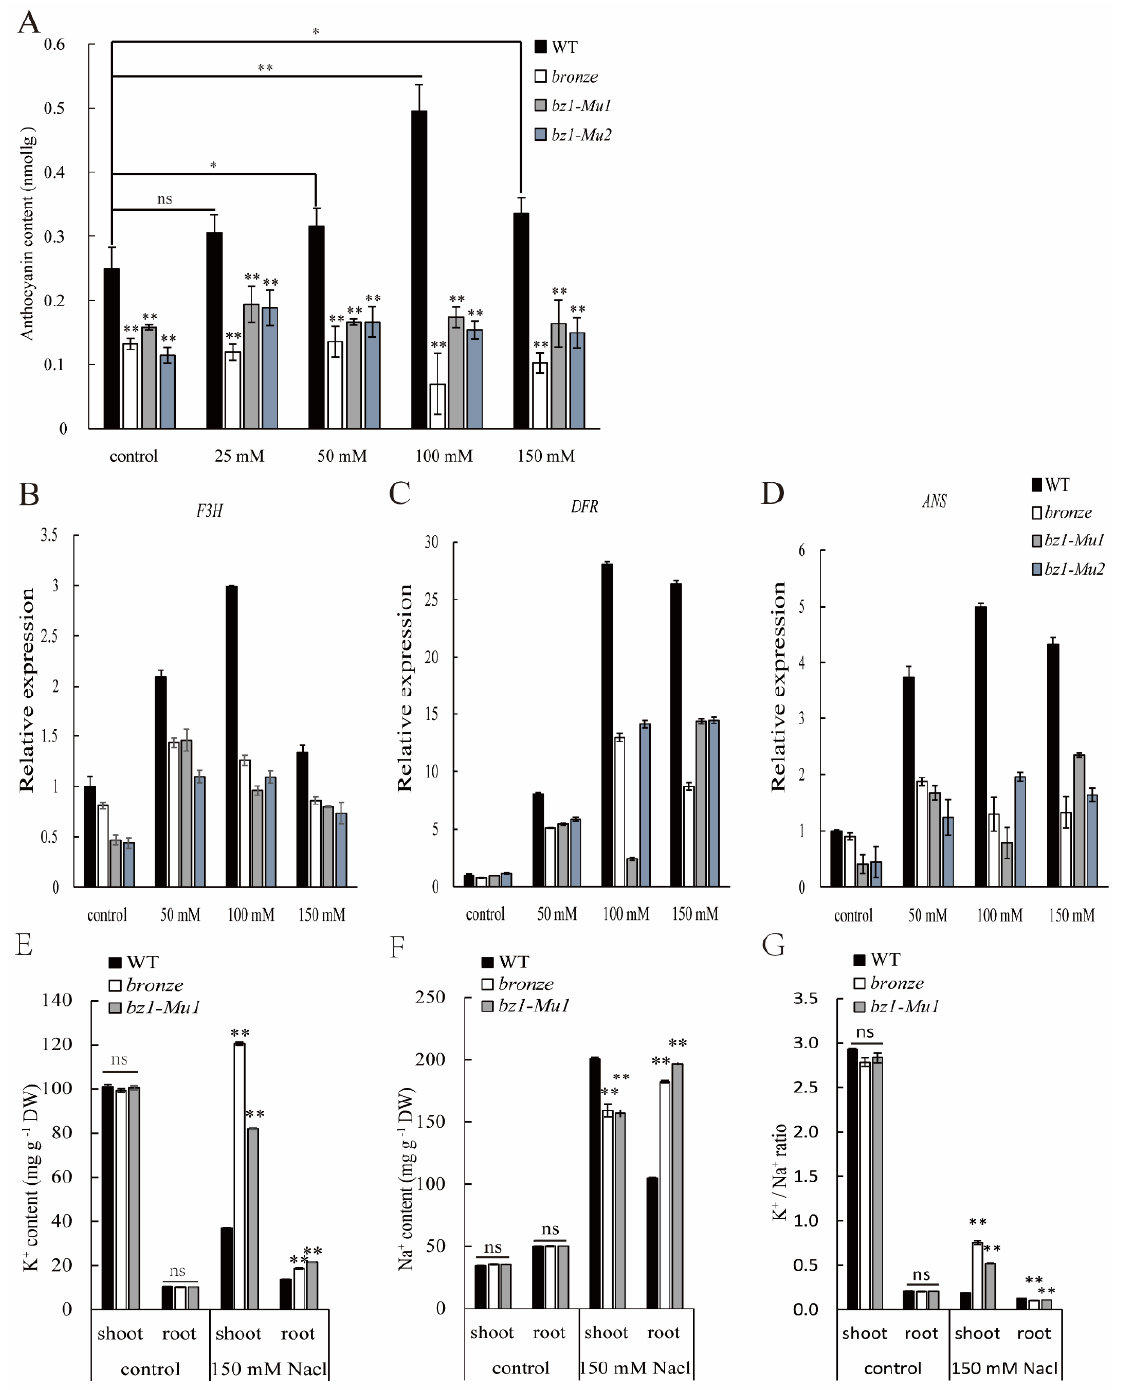
Figure 6. Anthocyanin accumulation was affected by altered ZmBZ1 expression. ( A ) The content of anthocyanins in three bz1 alleles and WT seedlings before and after salinity stress treatment. The asterisks indicate the significant difference relative to WT (Student t-test: * p < 0.05; ** p < 0.01; ns means no significant difference); ( B – D ) qPCR analysis of F3H ( B ), DFR ( C ) and ANS ( D ) expression in three bz1 alleles and WT seedlings before and after salinity stress treatment. GAPDH was used as an internal control. Values are shown as means ± SE, n = 3. ( E , G ) The content of K + ( E ), Na + ( F ) and K + /Na + ( G ) ratio in WT, bronze and bz1-Mu1 seedlings before and after salinity stress treatment. The asterisks indicate the significant difference relative to WT (Student t -test: * p < 0.05; ** p < 0.01; ns means no significant difference).